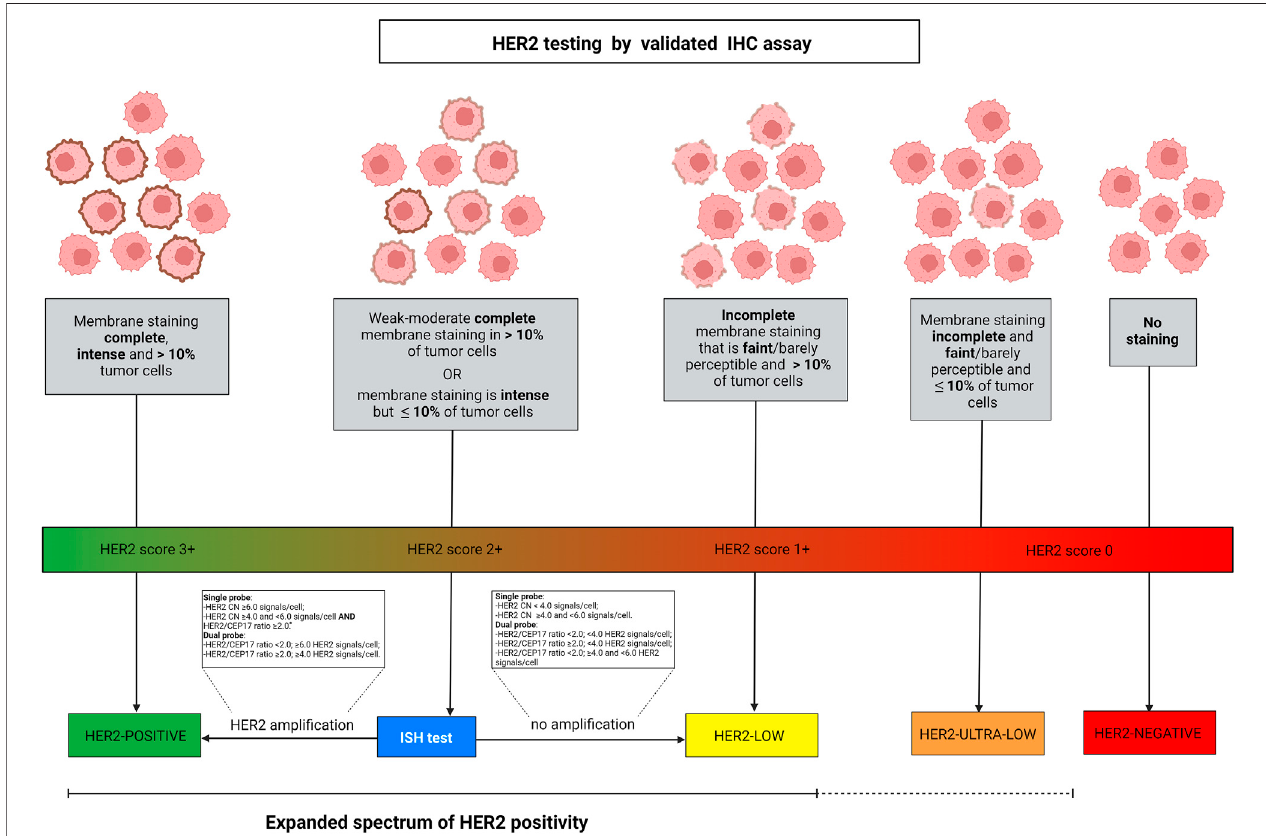
FIGURE 1 | Algorithm for de fi ning HER2 spectrum of expression according to ASCO/CAP guidelines. HER2-low diseases are identi fi ed by IHC score 2+ with negative ISH or IHC score 1+. Breast cancer is scored 2+ in case of weak-moderate complete membrane staining in > 10% of tumor cells or if the membrane staining is intense but in ≤ 10% of tumor cells. Score 1+ is de fi ned by faint or barely perceptible incomplete membrane staining in > 10% of tumor cells. Gene ampli fi cation by ISH is assessedasdetailedinthetextboxes,accordingtothetypesofprobesemployed.AmongtheIHCscore0category,twodifferenttypesofexpressionarepresent, namely a complete lack of expression and the faint or barely perceptible incomplete membrane staining in ≤ 10% of tumor cells. Albeit HER2-negative, this latter type of tumor indeed shows the expression of the protein and can be described as HER2 “ ultra-low ” . The continuous versus the discontinued line depicts the different levels of evidence in the current clinical practice. Abbreviations, IHC, immunohistochemistry; ISH, in situ hybridization; HER2, human epidermal growth factor receptor 2. *, dual- probe ISH should be performed for fi nal result. Source: Breast Biomarker Reporting, CAP Cancer Protocol Templates, v1.4.1.1, November 2021 update, available at: https://documents.cap.org/protocols/Breast.Bmk_1.4.1.1.REL_CAPCP.pdf. Created with